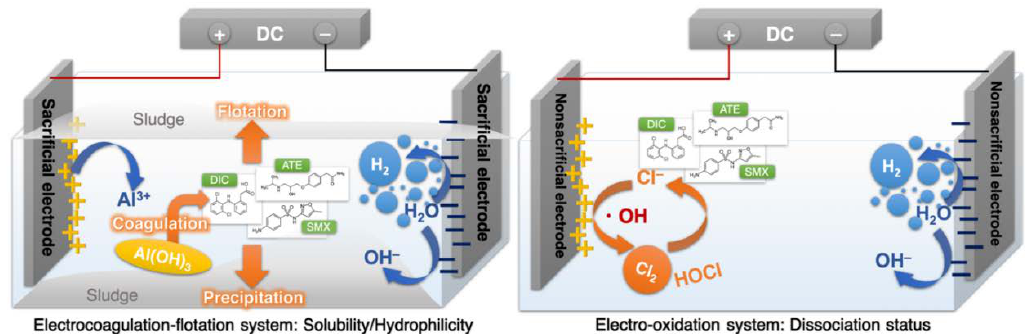
Figure 3. Schemes of the mechanism of electro-coagulation and electro-oxidation.